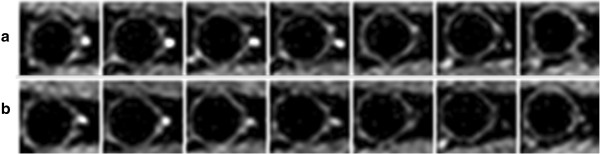
FMDA of femoral artery. All seven contiguous slices of a healthy 27 year-old right femoral artery at a) rest and b) 90s after the cuff deflation. In all slices the difference in lumen size representative of FMDA is well visualized. The average estimated FMDA is approximately 10%.